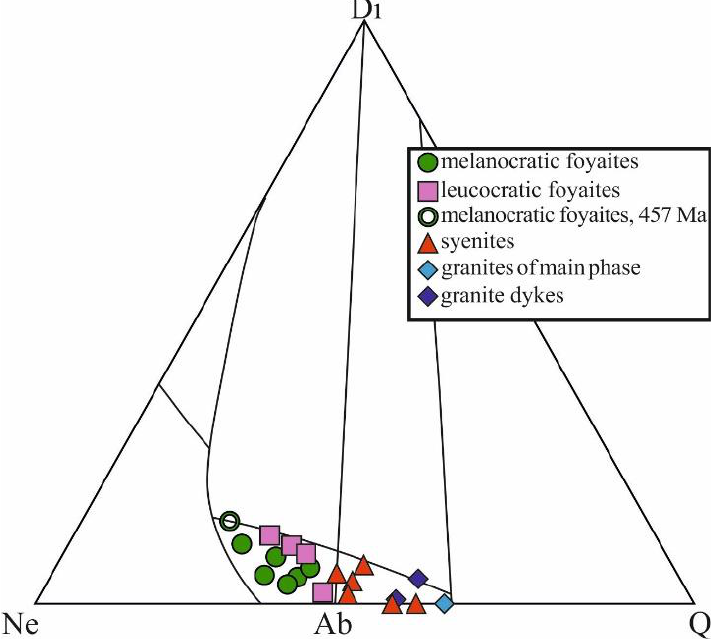
Figure 11. The normative Ne-Di-Q triangular diagram for the Saibar rocks [78]. The diagram illustrates that the syenites are intermediate between foyaites and granites. Ne = nepheline, Di = diopside, Ab = albite, Q = quartz.